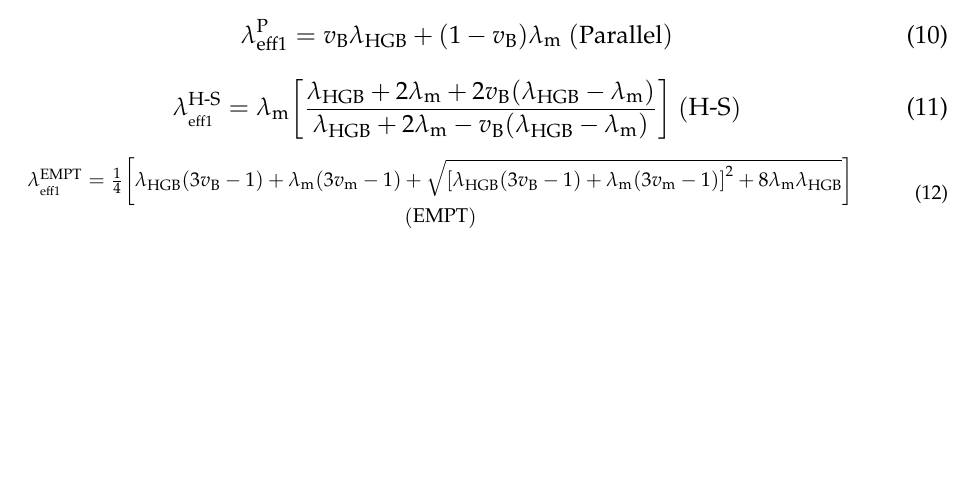
Figure 4. Distributions of the ( a ) temperature and ( b ) heat flow of RVE 1 along the y − direction; ( c ) heat flow of HGBs along the y − direction; and ( d ) heat flow of pure matrix with v B = 20% along the z − direction.